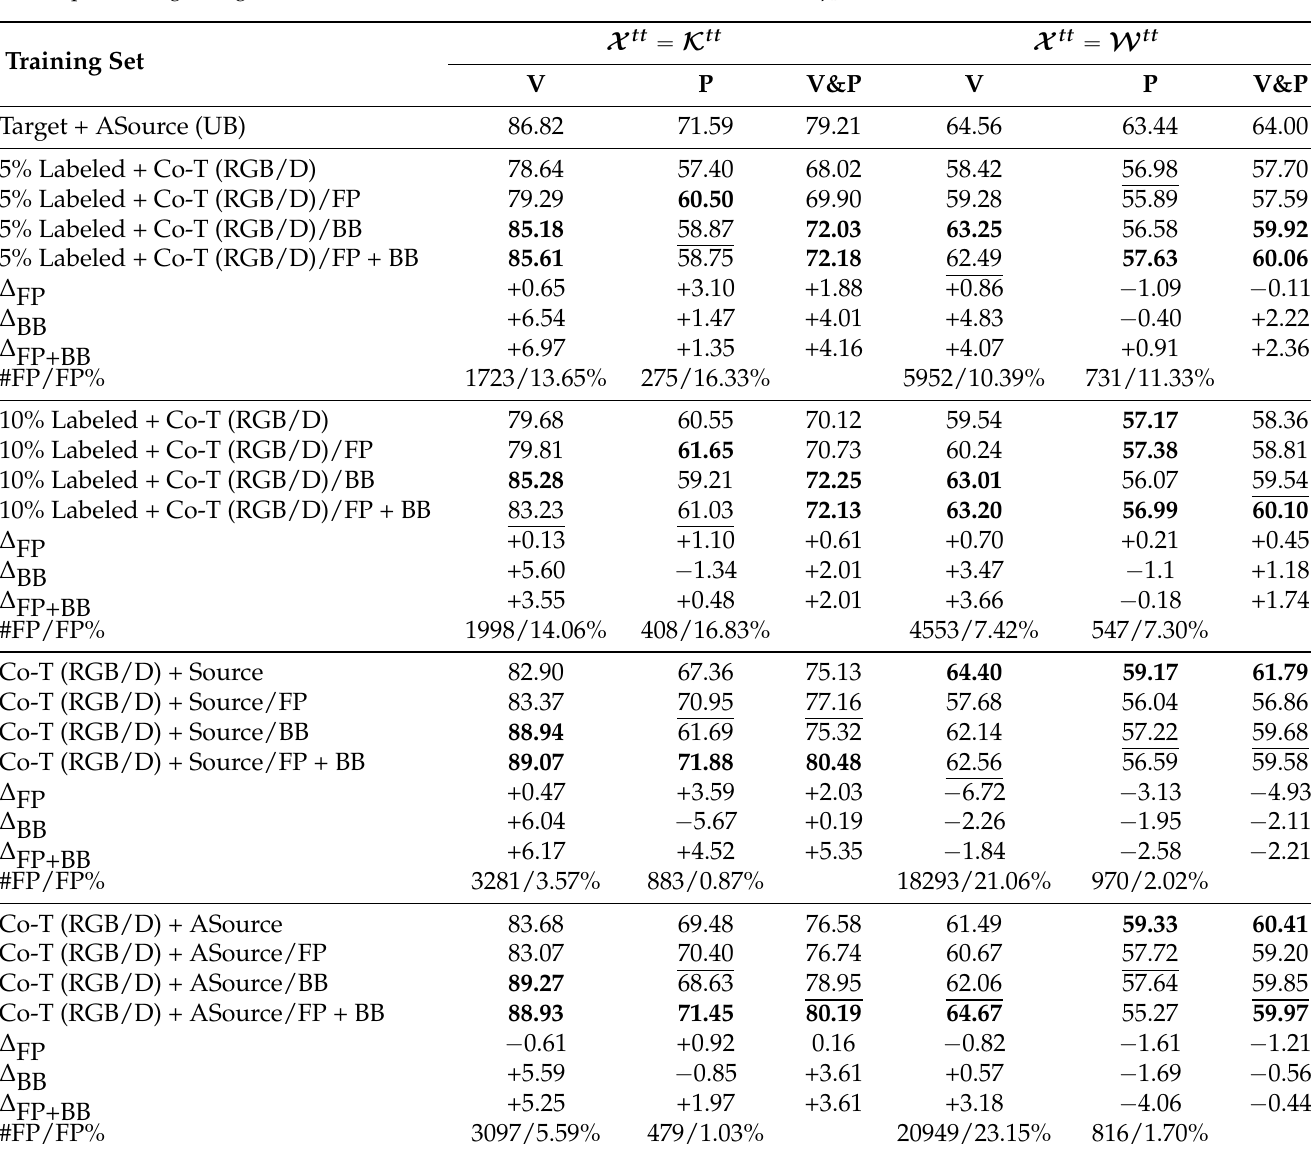
Table 7. Digging in the results throw three post-processing settings applied to co-training pseudo-labels: (FP) where we remove the false positive pseudo-labels; (BB) where we change the pseudo-labels by the corresponding GT (i.e., in terms of Figures 6–8, green BBs are replaced by red ones); (FP + BB) which combines both. This table follows the terminology of Tables 4–6. ∆ X , X P t FP, BB, FP + BB u , stands for difference of setting X minus the respective original (i.e., using the co-training pseudo-labels). Moreover, for each block of results, we add the #FP/FP% row, where #FP refers to the